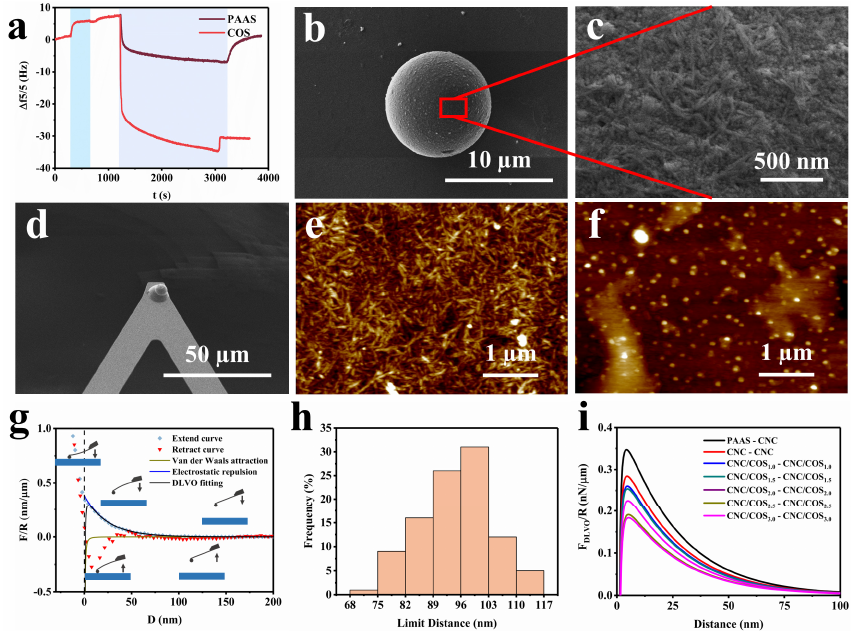
Figure 2. ( a ) QCM − D studies of PAAS and COS adsorption on a CNC − coated sensor surface. ( b ) SEM image and ( c ) enlarged view of the CNC − modified silica microsphere. ( d ) SEM image of a modified AFM probe equipped with a SiO 2 microsphere (diameter of 10 μ m). AFM images of ( e ) CNC − coated substrate and ( f ) PAAS − coated substrate, respectively. ( g ) The force − distance curves and the DLVO fitting curves of CNC − CNC and schematic diagram of the AFM force testing process. ( h ) The limit distance of the interaction of CNC − CNC. ( i ) The DLVO re − fitting curves.